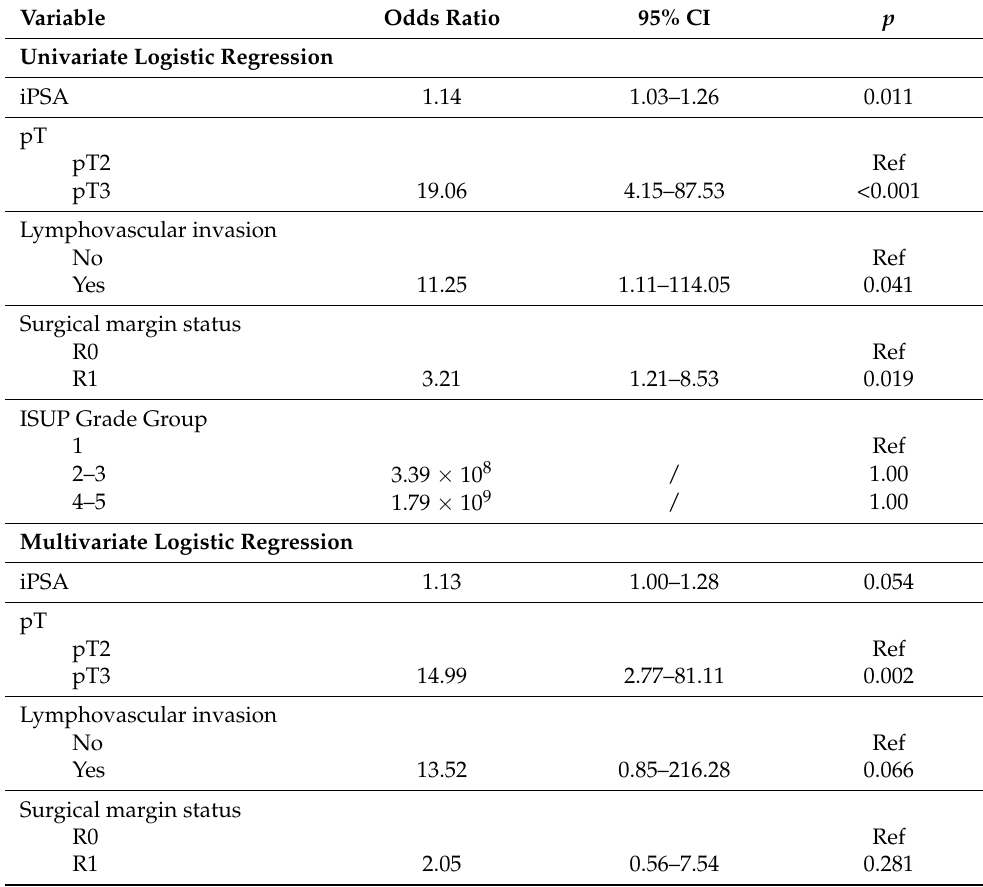
Figure 2. Comparison of biochemical recurrence free-survival between RS-RARP (green line) and SA-RARP (blue line). Table 5. Univariate and multivariate logistic regression analysis for biochemical recurrence in the RS-RARP